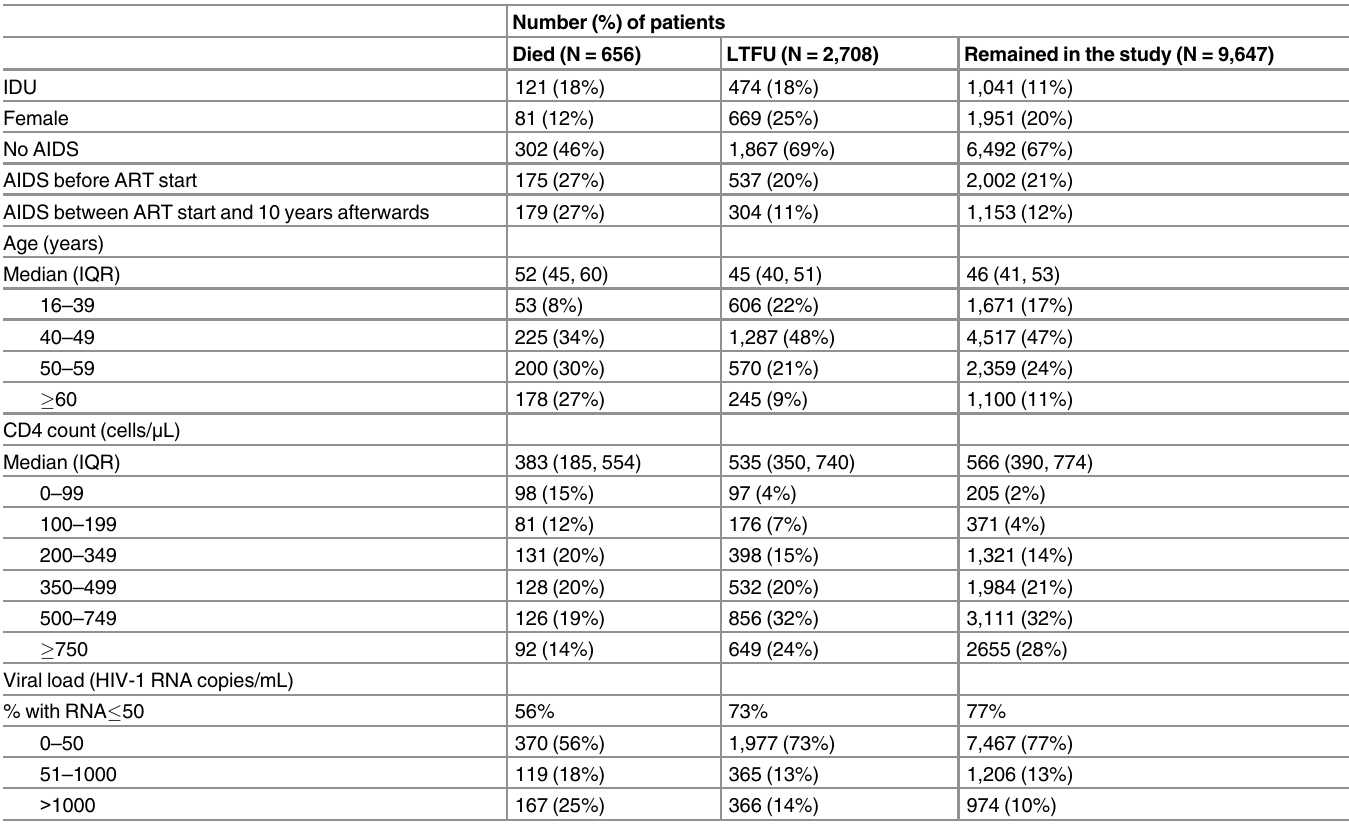
Table 2. Characteristics of patients followed from 10 years after start of ART who died, were lost to follow up (LTFU) or remained in the study until end of follow